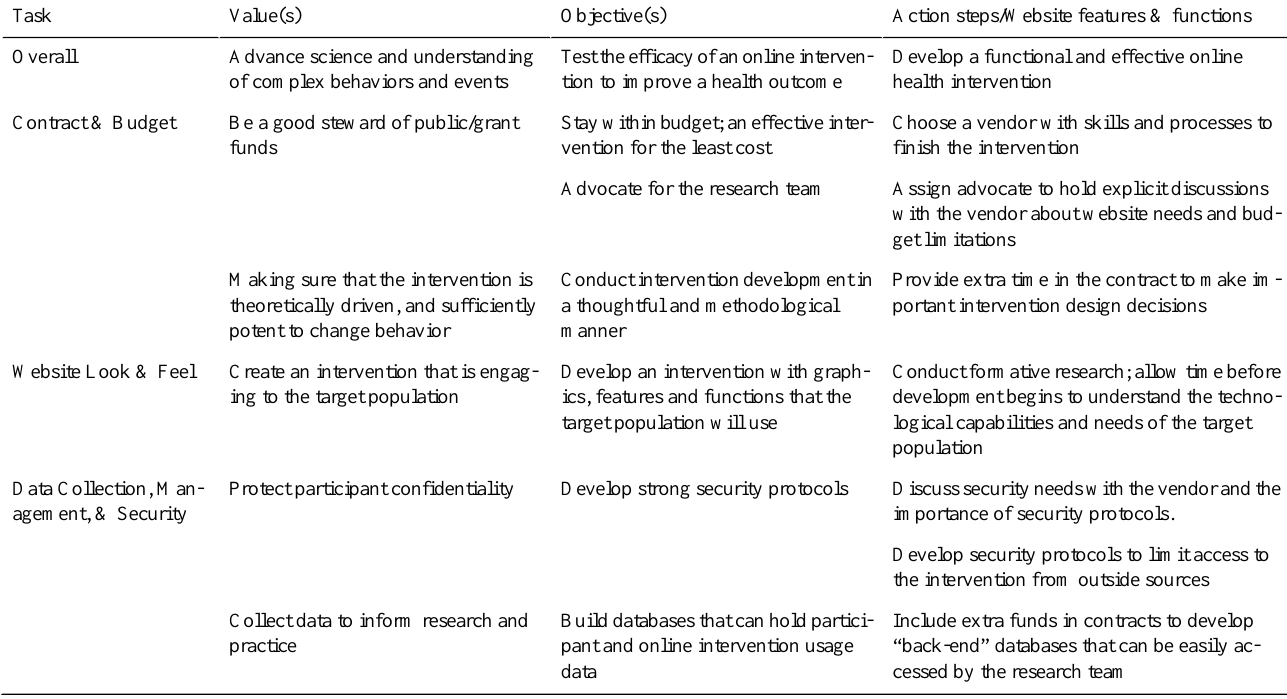
Table 2. Example values and objectives from a research